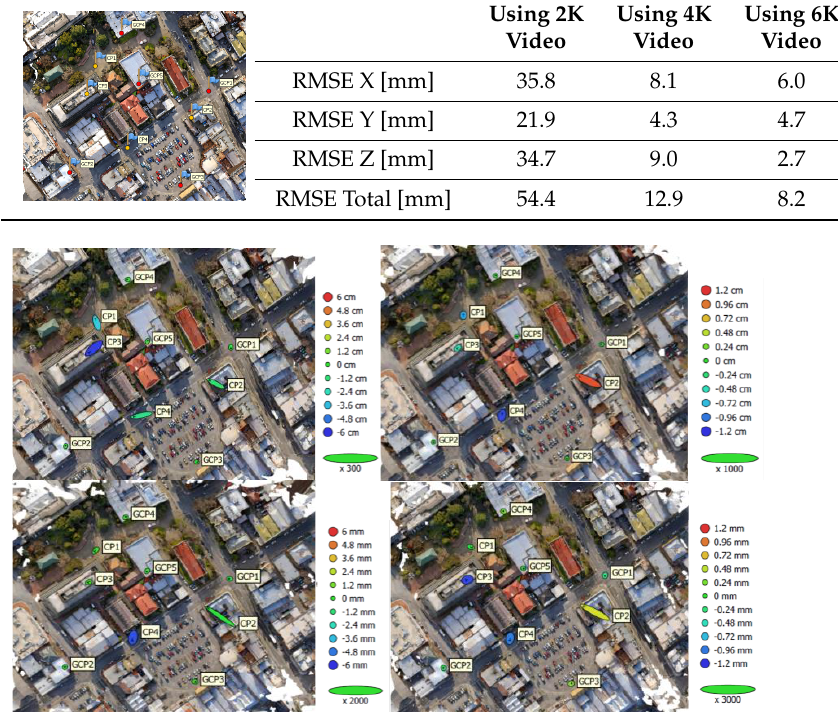
Figure 10. Checking the internal accuracy of the first test. ( a ) The selected planar roof (dashed area) for testing the relative accuracy. ( b ) Planar fitting relative error evaluation at the four video resolutions (red > 1 cm, blue < − 1 cm). For external accuracy assessment, we used nine reference points represented by one squared-meter coded target distributed all over the area where five are used as GCPs and four as checkpoints. Table 2 and Figure 11 illustrate the RMSE achieved in the checkpoints. Noticeably, the coded targets are not detected at the 2K drone video, only two at the 4K video, most of the targets at the 6K video, and the full target set at the 8K video. Reason- ably, this is highly related to the video resolution and GSD values. Table 2. Estimated RMSE at the four checkpoints distributed over the area at the four drone video resolutions.